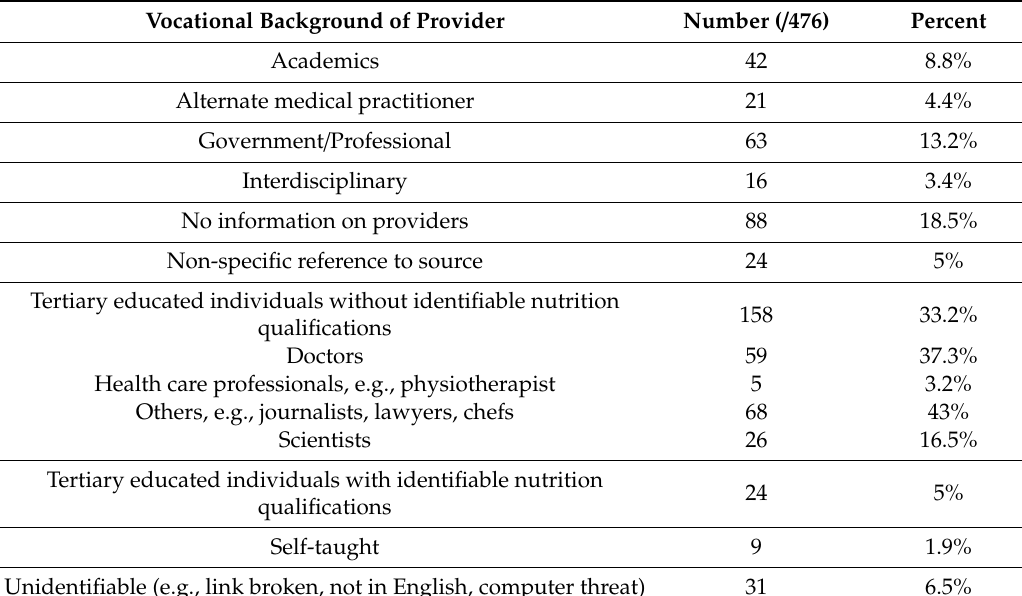
Table A6. Results for Provider Vocational